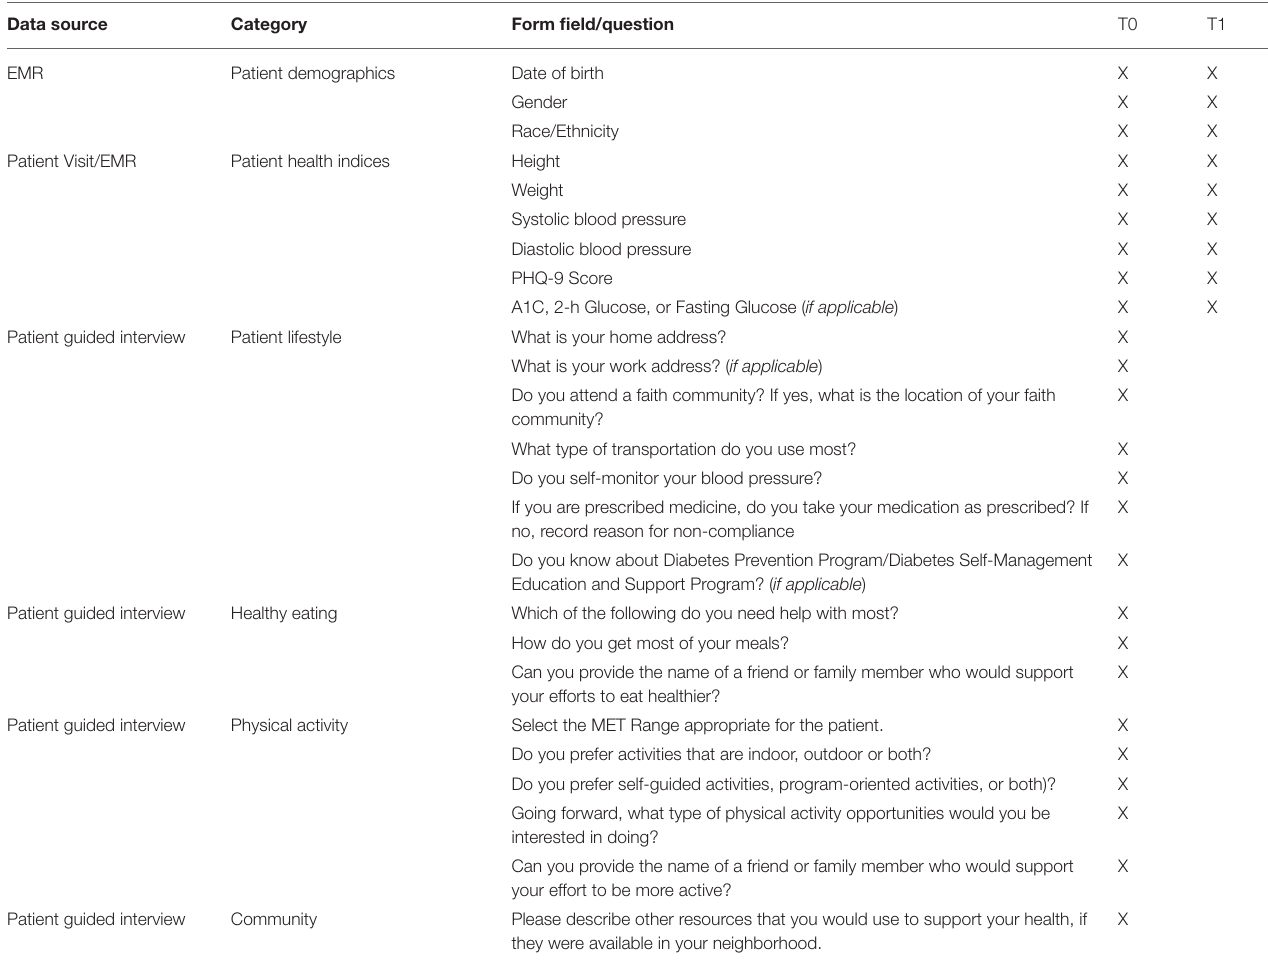
TABLE 3 | Patient Intake Form for GPI